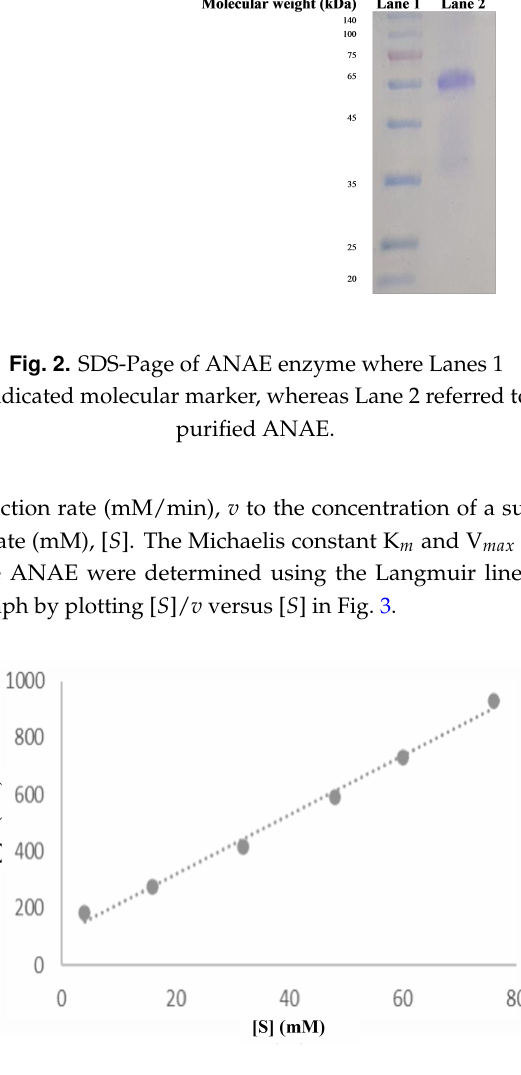
Fig. 3. Langmuir plot of ANAE activity